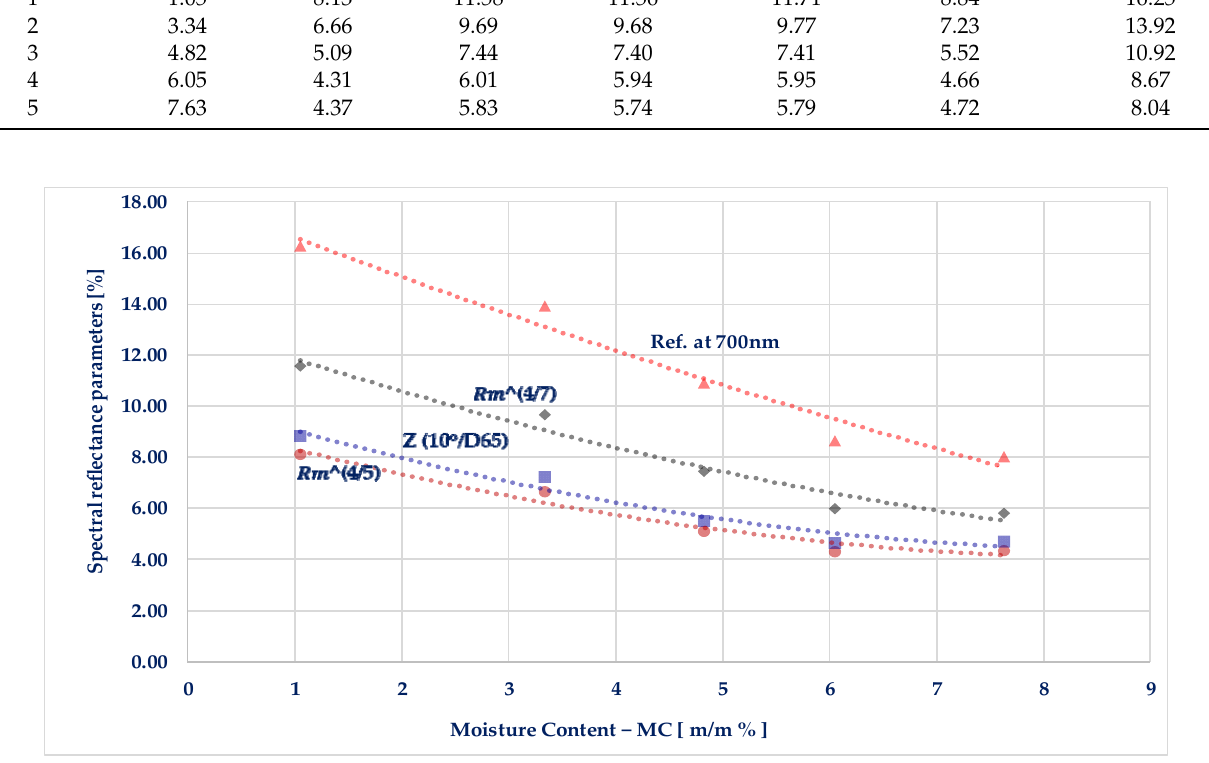
Figure 8. Spectral reflectance parameter–moisture content relationship.